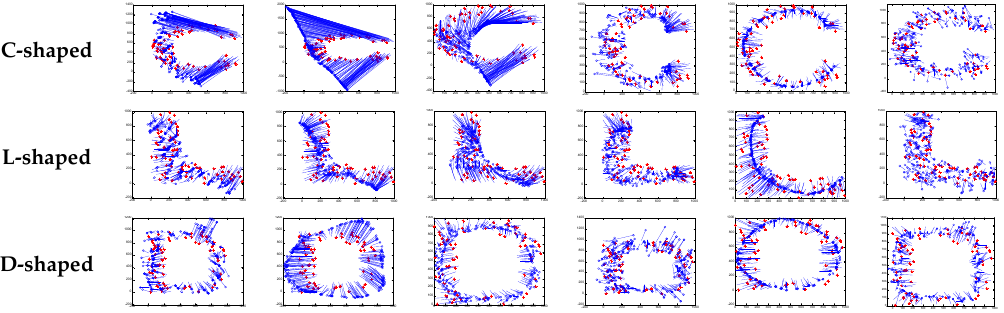
Figure 8. The localization results of the six algorithms in random deployment networks.